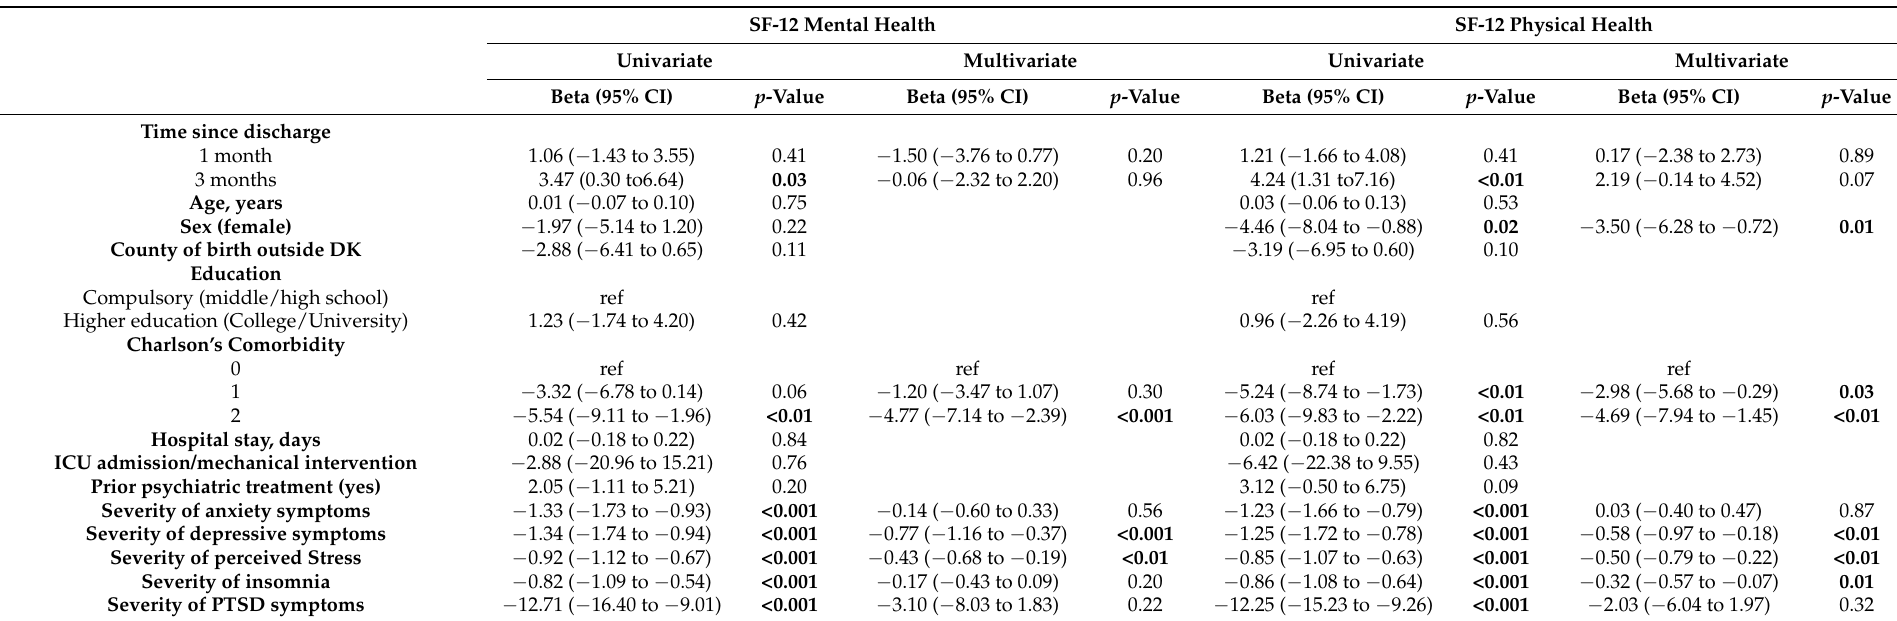
Bootstrapped univariate mixed linear regression models were performed with the variable of interest as the independent variable and a random intercept for each participant. Each variable with a p -value of <0.10 in the univariate model was included in the multivariate model. Variables with a p -value < 0.5 in the multivariate model were identified as the factors significantly associated with the outcome (highlighted in